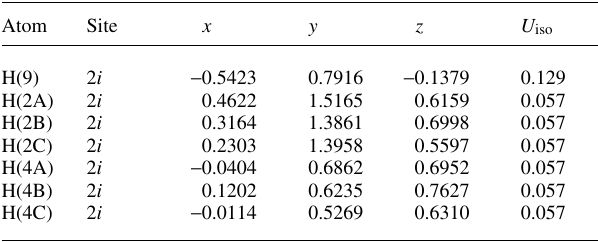
Table 2. Atomic coordinates and displacement parameters (in Å 2 )